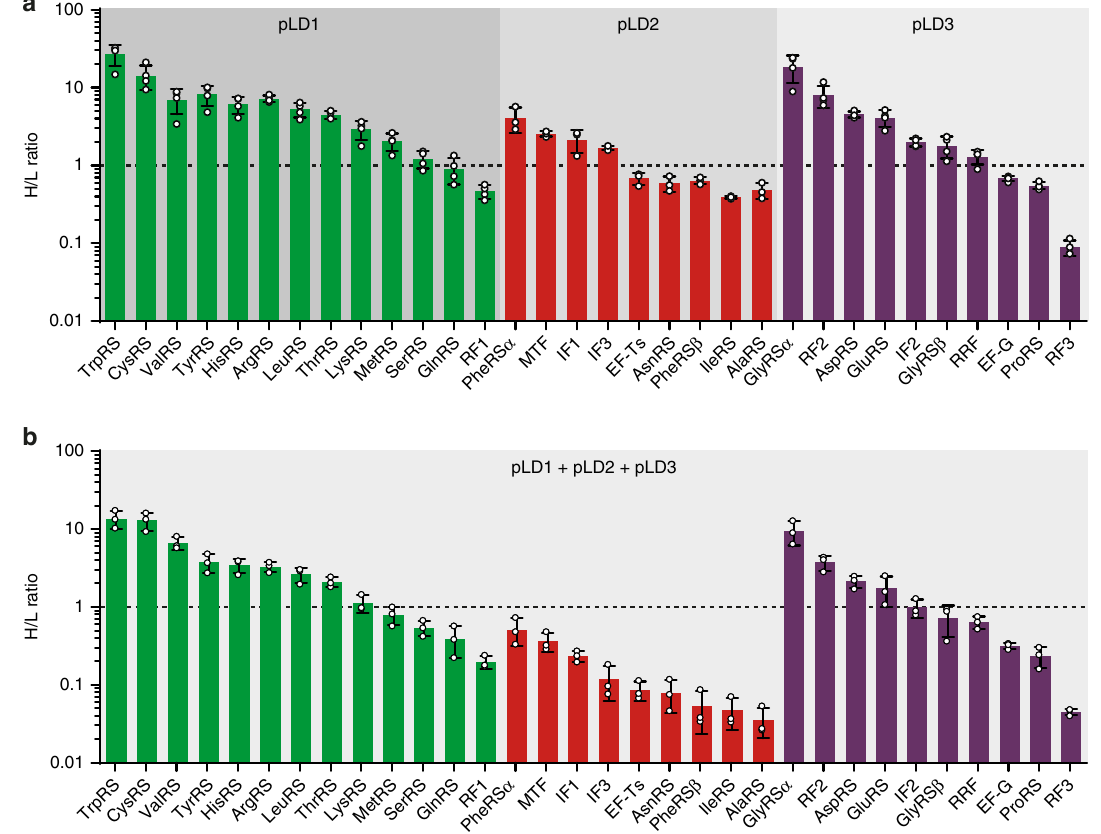
Fig. 4 A substantial number of TFs are ef fi ciently expressed during co-replication of pLD1, plD2, pLD3 and pREP. a H/L ratios of the 32 TF protein subunits after 15 N 2 13 C 6 -lysine and 15 N 4 13 C 6 -arginine incorporation during in vitro transcription/translation of pLD1 (green, n = 4), pLD2 (red, n = 3) or pLD3 (purple, n = 4) in PURErep overnight reactions. The line H/L = 1 indicates full regeneration of a protein to its respective input concentration. b Expression levels during parallel TTcDR of pLD1 (green), pLD2 (red) and pLD3 (purple) during TTcDR induced by the addition of pREP. All H/L values are means + / − s.d. ( n = 3) from biological replicates triplicates using different PURErep batches. Source data are available in the Source Data fi